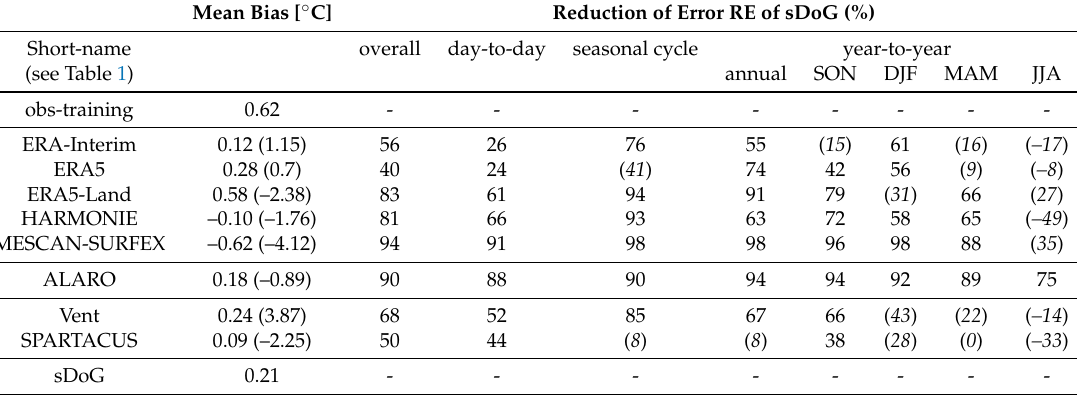
Table 2. Overview about the added value of sDoG over all considered reference data sets and at all considered time scales in the true evaluation period. The first column shows the biases of all reference data sets and sDoG (last row) to obs-trueval (true evaluation observations from 1979 to 2001). The values in brackets are the biases of the reference data sets without bias correction, thus including the altitude bias. The remaining columns show the added value in terms of reduction of error RE (Equation (1)) of sDoG over all assessed reference data sets (top to bottom) at different time scales (left to right). Values of RE not found to be significantly positive (at a 5% significance level) are shown in brackets. Negative scores are given for completeness, but are not equivalent to RE of a reference data set over sDoG, because the range of RE is ( − ∞ ,1 ] see